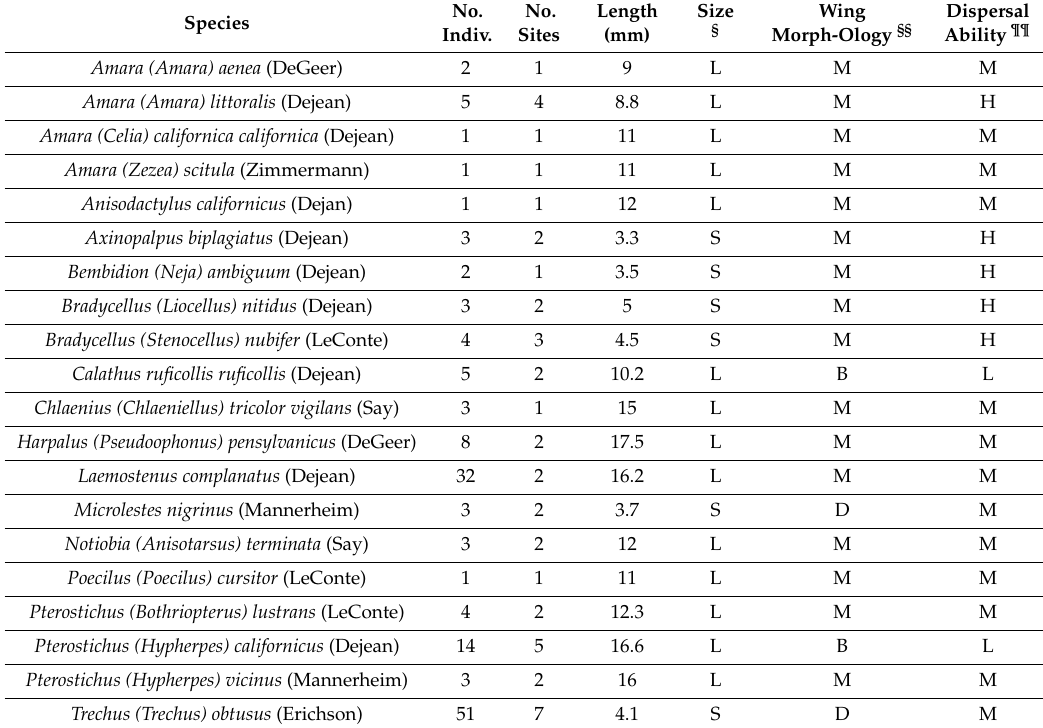
Table 1. Identity and functional traits of Carabidae beetle individuals collected from 19 urban garden sites in the central coast of California. No. Species